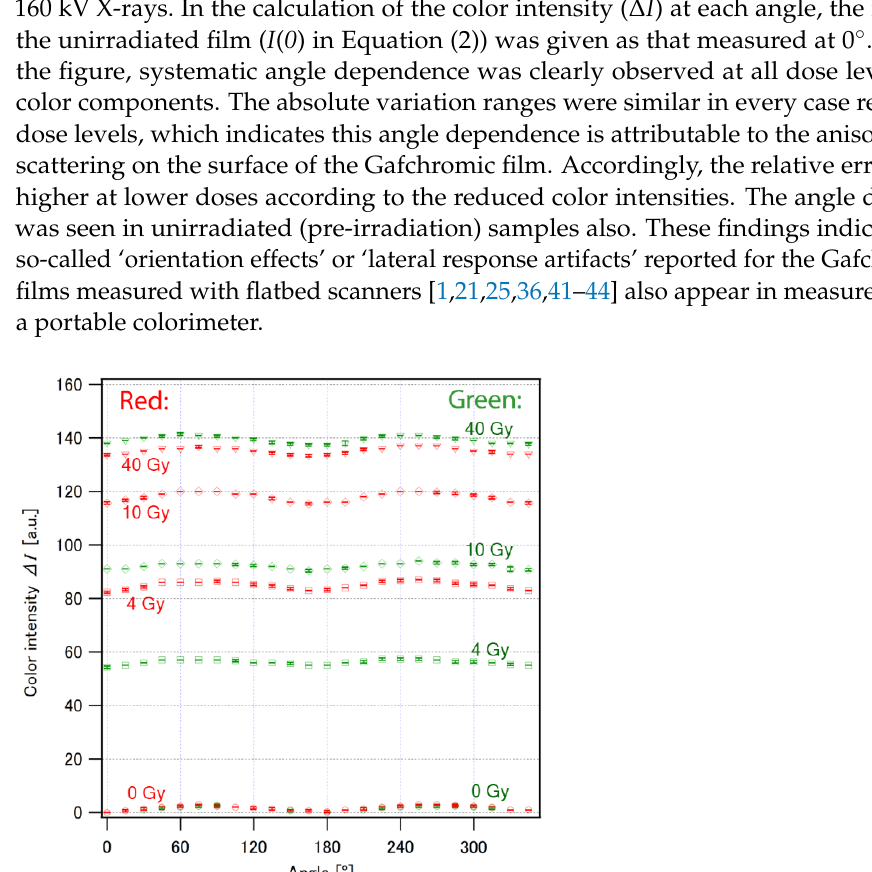
Figure 3. Dose dependences of the color intensities of EBT-XD irradiated with 160 kV X-rays at up to 40 Gy as to RGB, red, green and blue components measured with Nix at the angle of 0°.